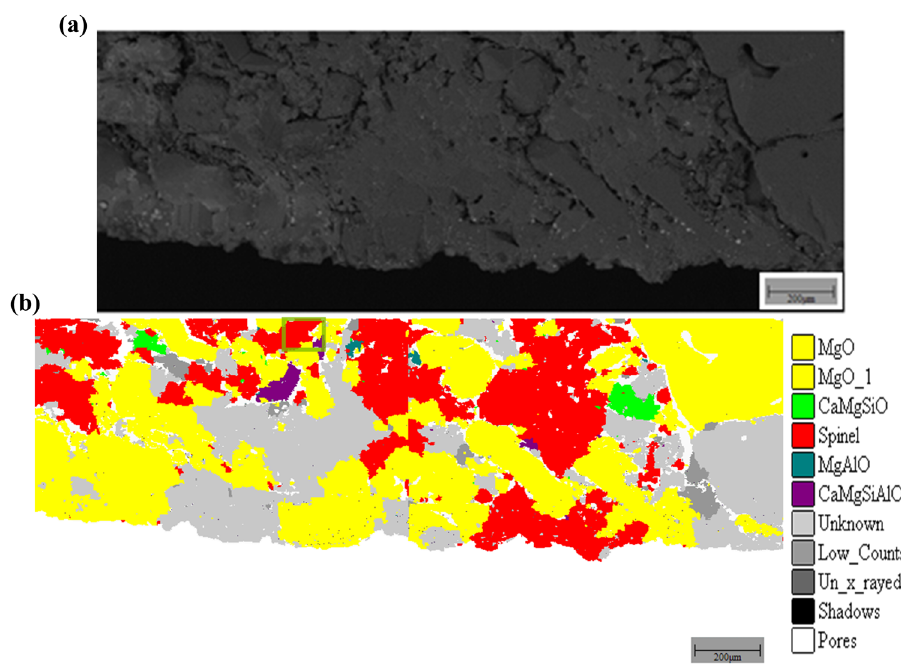
Figure 12: ( a ) MgO · Al 2 O 3 crucible backscattered electron image; ( b ) MgO · Al 2 O 3 crucible mineral phase